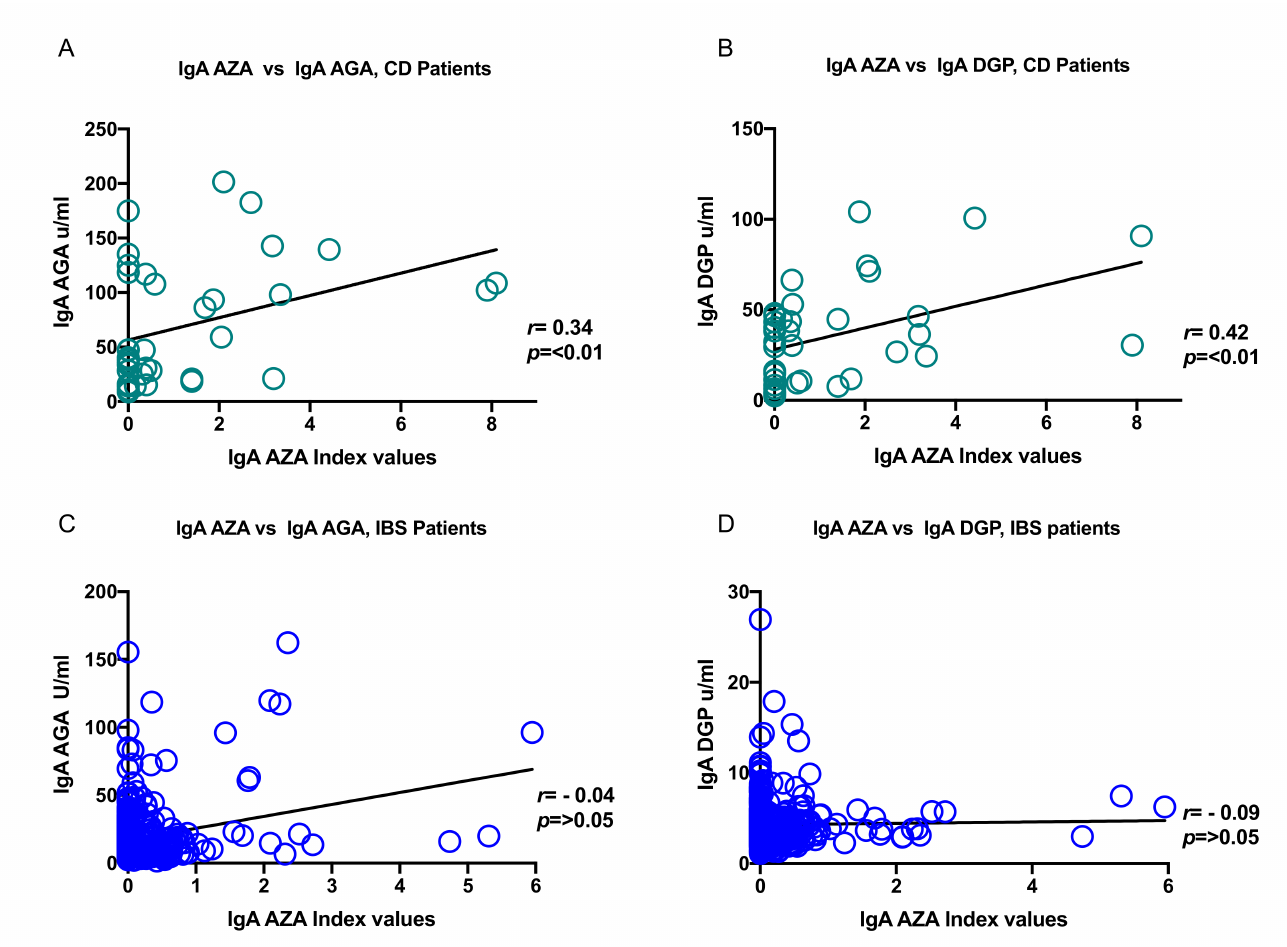
Figure 3. Correlation analysis between IgA AZA and IgA AGA in CD and IBS patients. ( A ) IgA AZA vs. IgA AGA serum levels in celiac disease patients, ( B ) IgA AZA vs. IgA DGP serum levels in celiac disease patients, ( C ) IgA AZA vs. IgA AGA serum levels in IBS patients, ( D ) IgA AZA vs. IgA DGP serum levels in IBS